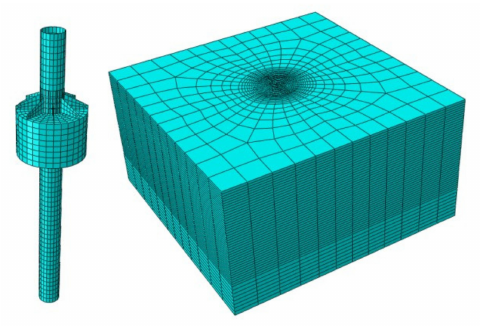
Figure 3. Meshing of